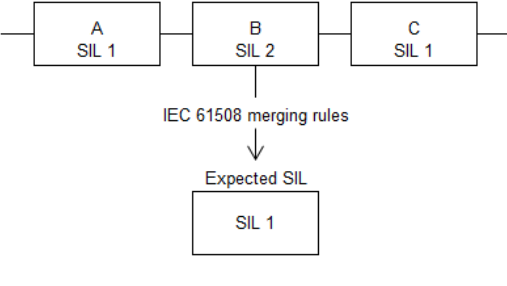
Fig. 5. SIL series merging rule in IEC 61508 (b) Parallel merging rule: the SIL of a parallel structure is given by the SIL of the subsystem with the highest SIL, refer to Fig. 6.